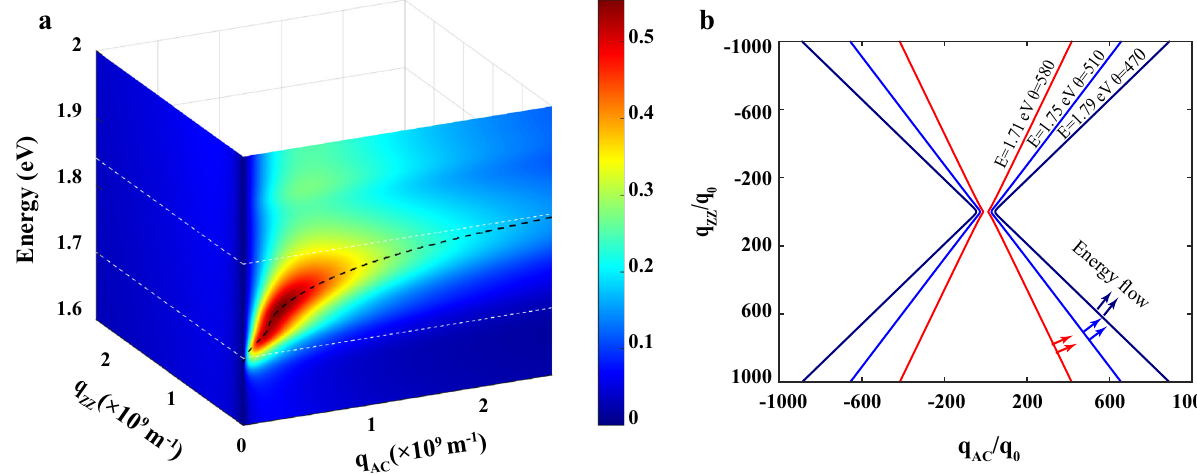
Fig. 3 Hyperbolic exciton-polariton dispersion. a The calculated loss function (cid:3) Im ð 1 = ε Þ is displayed as a pseudo-color map. The EPs are highly anisotropic. The two white dashed lines mark the hyperbolic dispersion regime. The black dashed curve represents the dispersion. b Iso-frequency contours of EPs at different energies ( E = 1.71 eV, 1.75 eV, 1.79 eV). The asymptote angle θ is labeled for each contour. The open iso-frequency contour indicates the (cid:3) θ or π þ θ ) orthogonal to the iso-frequency contour, as indicated by the double hyperbolicity, with the propagating direction ( π 2 2